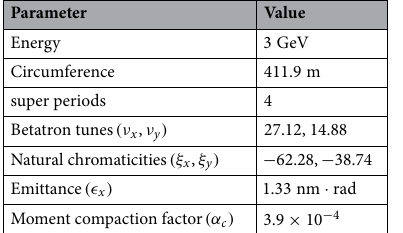
Table 1. Main parameters of the storage ring shown in Fig.